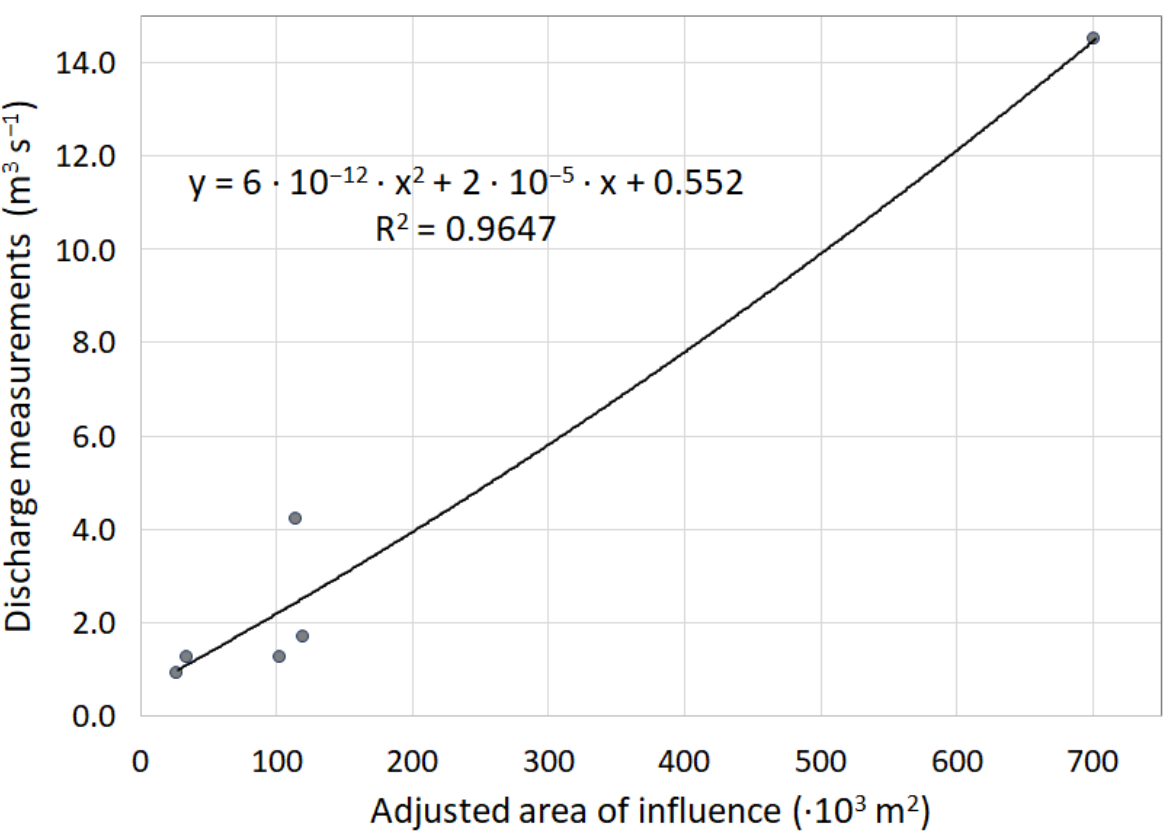
Figure 5. Correlation between adjusted area of influence and discharge measured at the Rjeˇcina’s outlet.